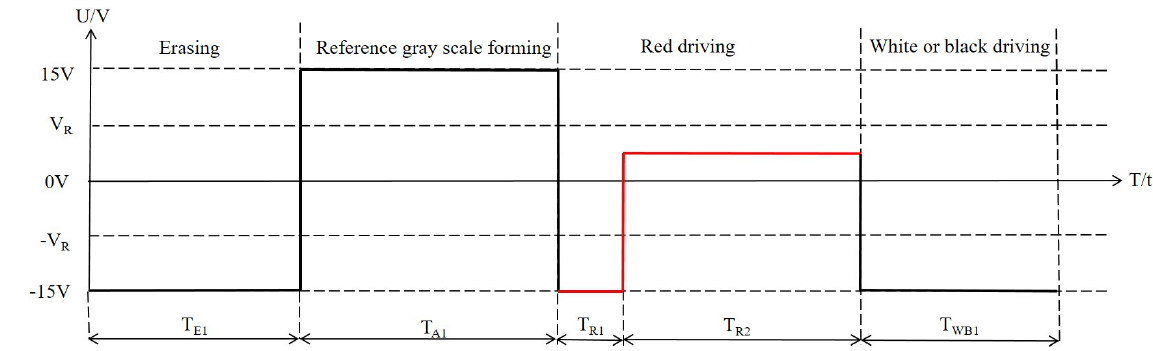
Figure 4. The proposed driving waveform of three-color EPDs. It was composed of an erasing stage, a reference gray scale forming stage, a red driving stage, and a white or a black driving stage. T E 1 is the driving time of the erasing stage, T A 1 is the driving time of the activation stage, T R 1 is the driving time of a − 15 V driving voltage in the red driving stage, T R 2 is the driving time of a positive DC voltage in the red driving stage, T WB 1 is the driving time of the white or the black driving stage. V R is the driving voltage of red particles.